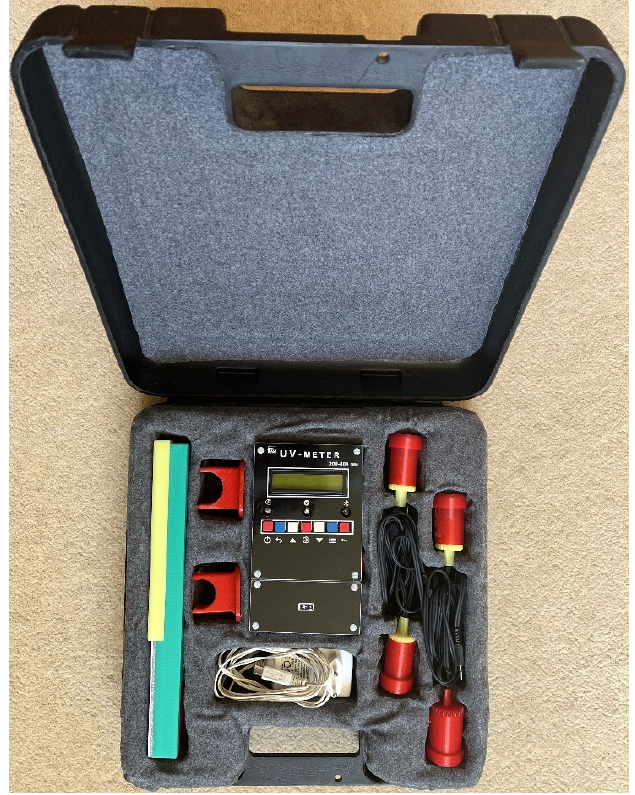
Figure 14. The whole setup.